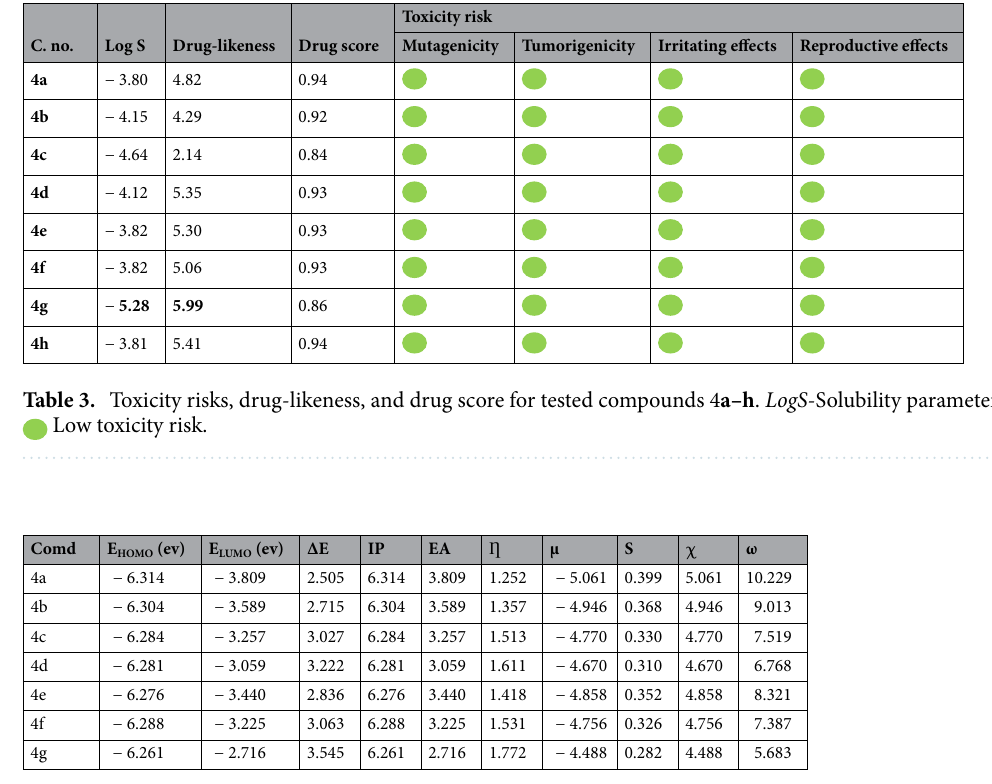
Table 4. Frontier orbitals energy and global reactivity descriptors of compound 4a–g.